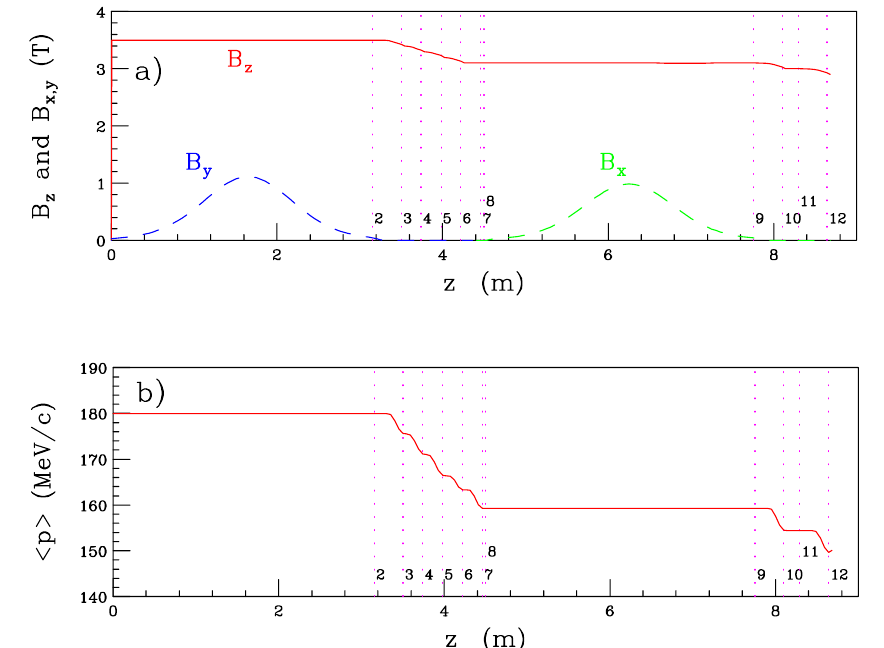
FIG. 30. (Color) (a) Axial B z and dipole B y , B x , magnetic fields, and (b) average momentum, both as a function of the position along the cell.